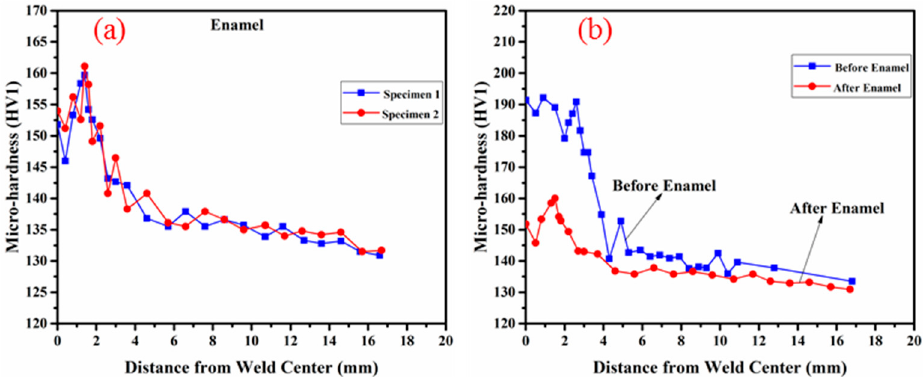
Figure 15. Micro-hardness distribution of longitudinal weld ( a ) after enameling ( b ) contrast of before and after enameling.